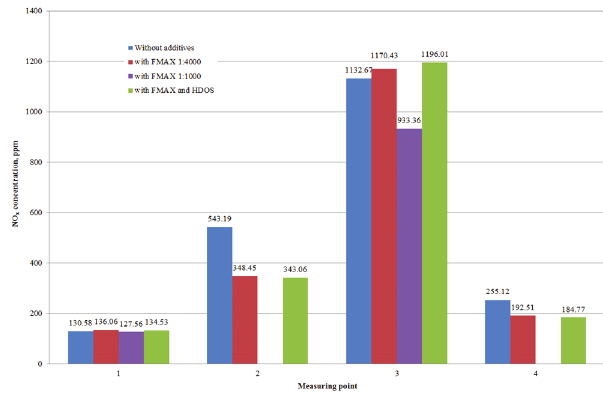
Fig. 3. Concentrations of NO x measured in tests